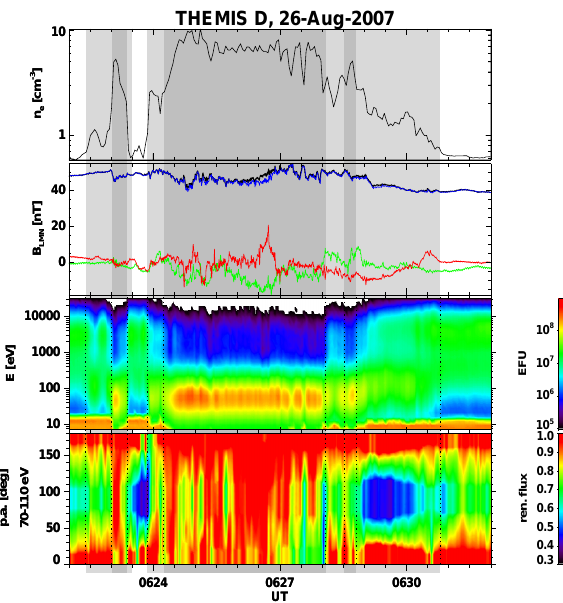
Fig. 10. Event 2. The electron density; the magnetic field in the LMN coordinate system (L – red; M – blue; N – green and magni- tude – black); electron energy spectra; and normalized pitch-angle distribution of 70–110eV electrons at the 06:22–06:32UT time in- terval. The dark and slight grey areas denote the outer and inner LLBL, respectively, and the black lines show crossings of the cur- rent sheet.